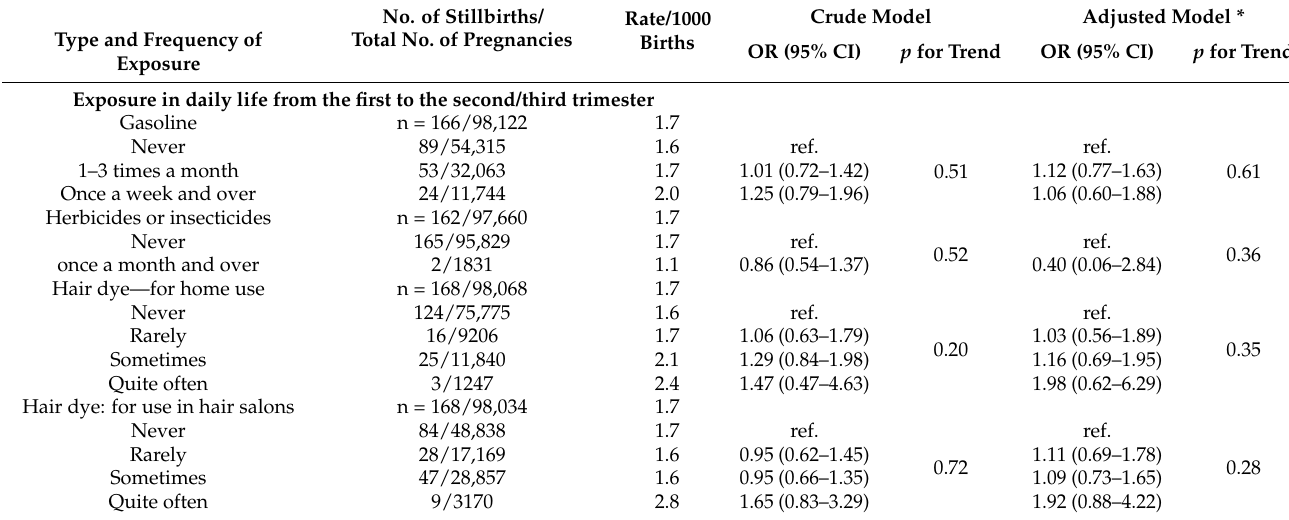
Table 4. Adjusted odds ratio of stillbirth occurrence for exposure to daily life from the first to the second/third trimester. No. of Stillbirths/ Crude Model Adjusted Model * Rate/1000 Total No. of Pregnancies Type and Frequency of Births OR (95% CI) p for Trend OR (95% CI) p for Trend Exposure Exposure in daily life from the first to the second/third trimester Gasoline